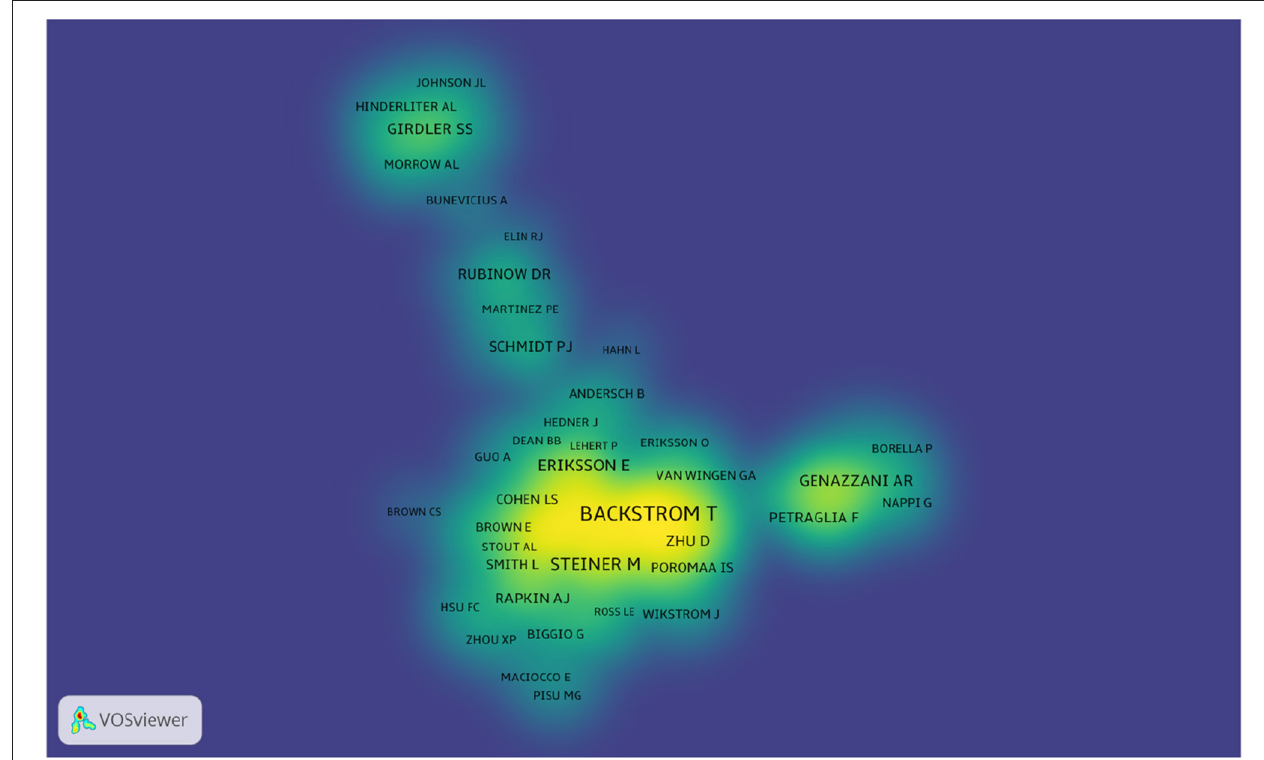
FIGURE 6 | Map of authors that published articles on PMS/PMDD during 1945–2018.